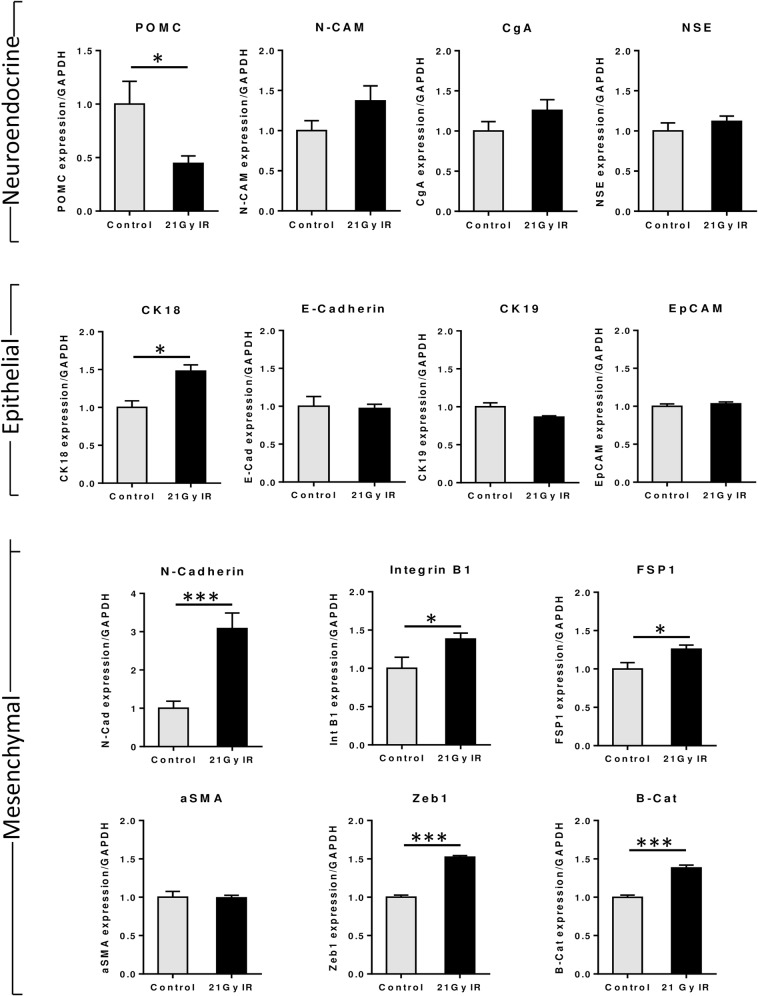
IR primed DMS 79 cells have reduced POMC gene expression.mRNA expression was analysed in DMS 79-IR cells (grey bars) and untreated cells which were grown in parallel conditions to the treated cells (black bars). mRNA levels were normalised to GAPDH expression. *p<0.05 ***p = <0.001.